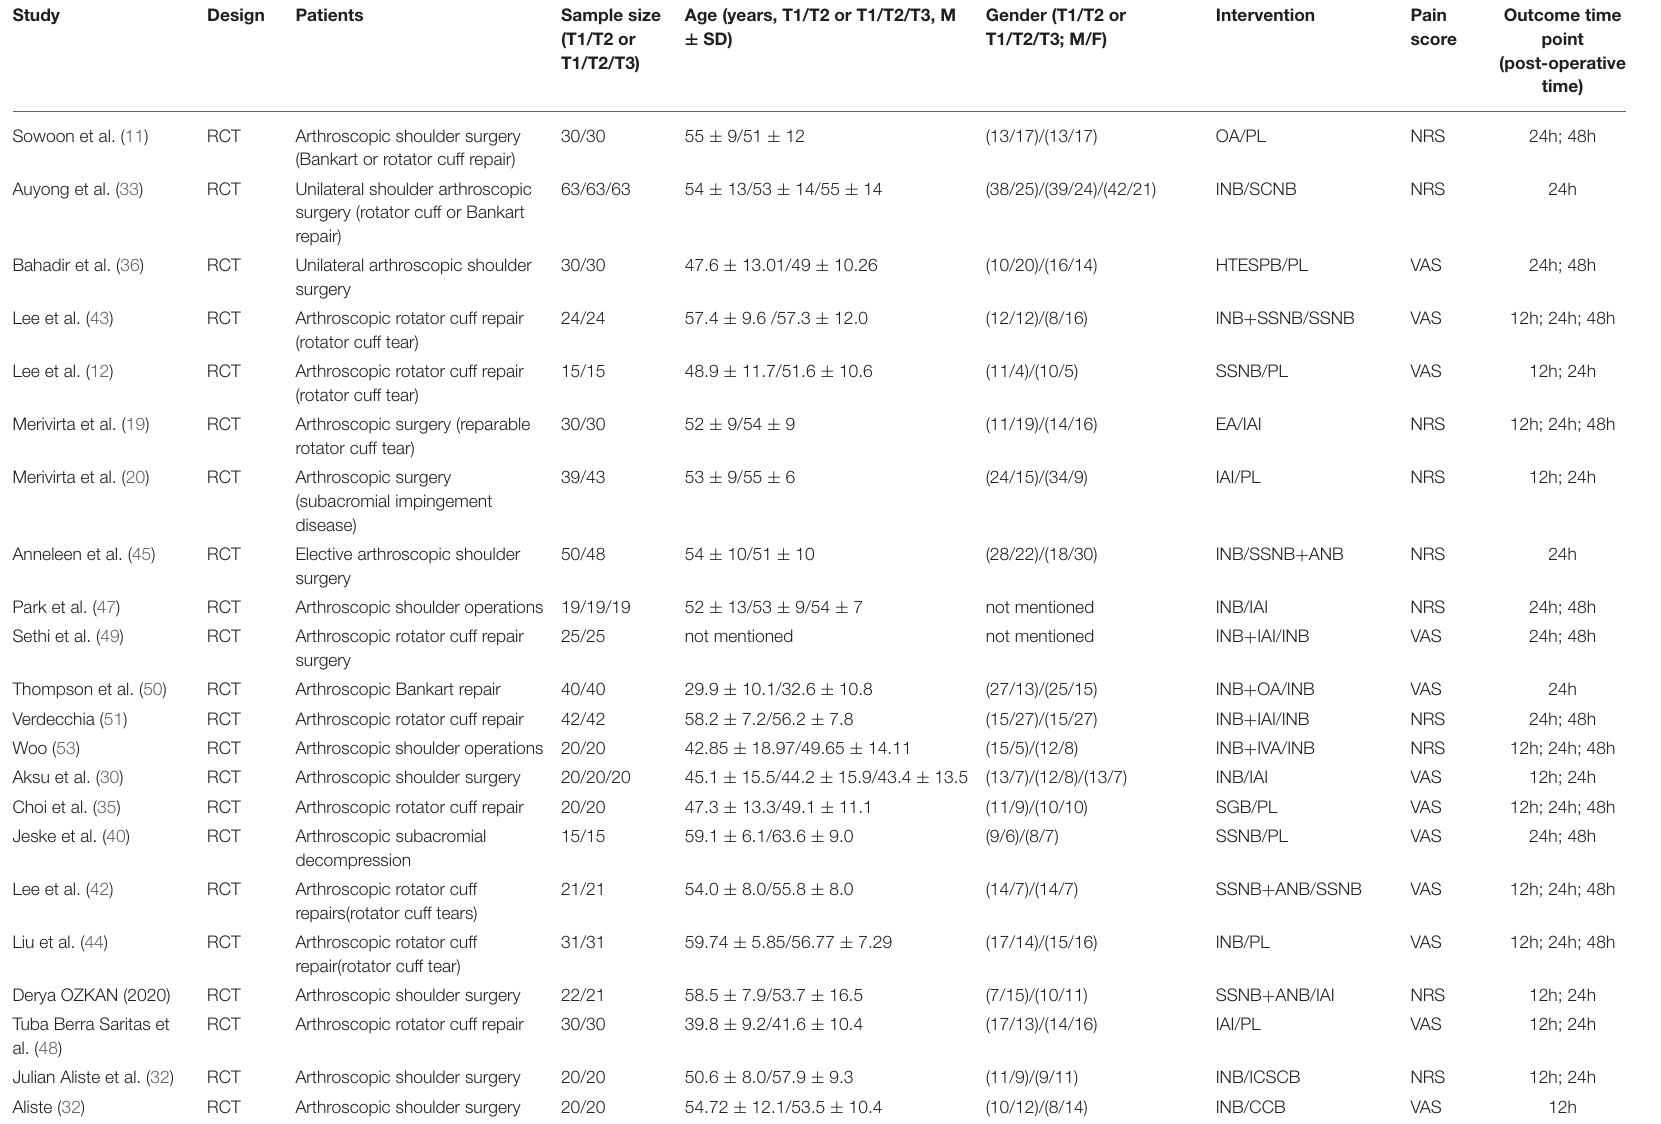
TABLE 2 | Characteristics of the included